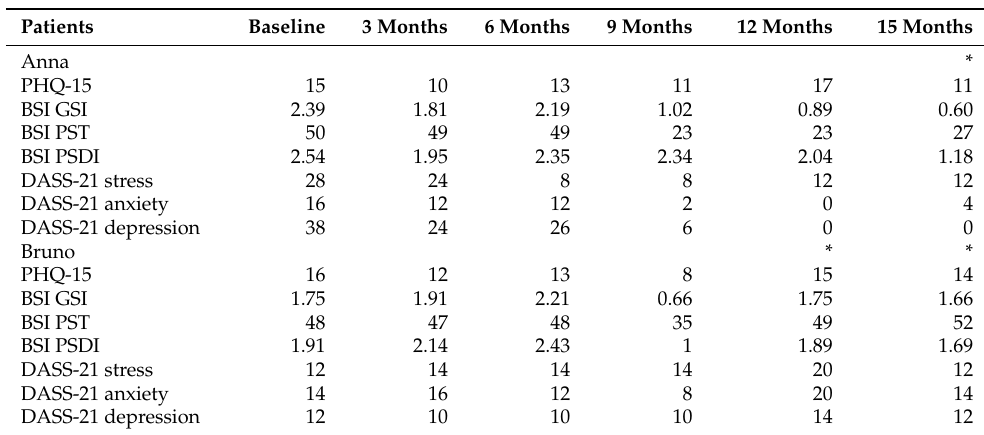
Table 2. Patients’